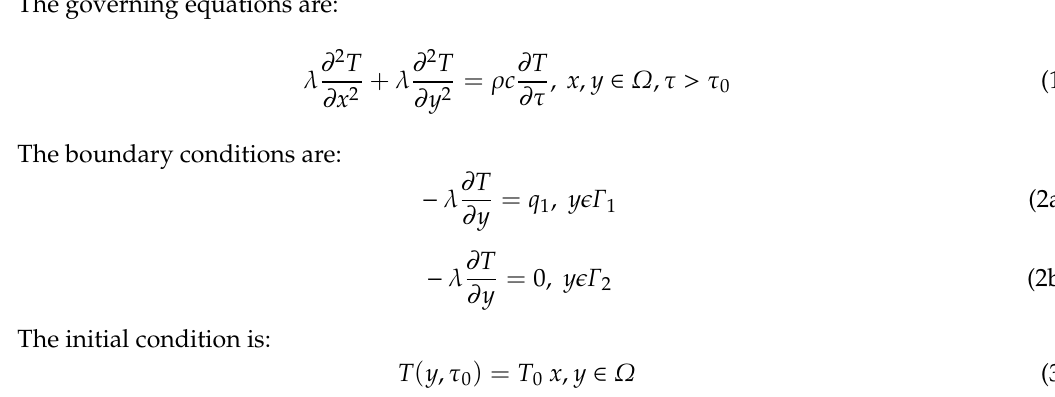
Figure 1. Two-dimensional unsteady-state heat transfer model.